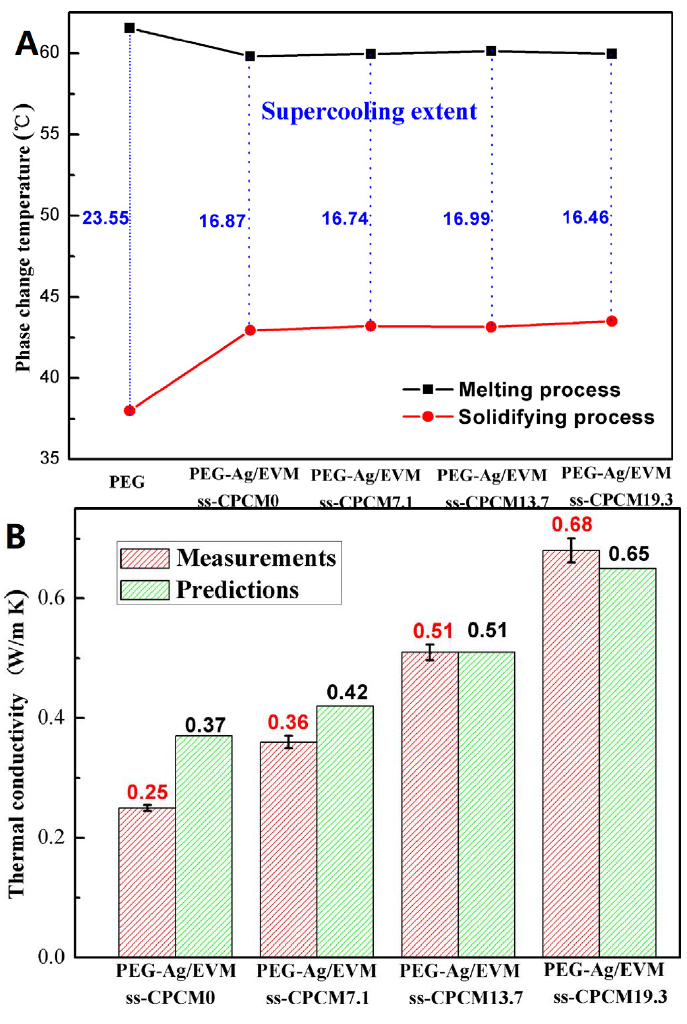
Figure 14. ( A ) Supercooling degrees of PEG and PEG-Ag/EVM ss-CPCMs with different concentration of AgNWs and ( B ) measured and predicted thermal conductivities of PEG-Ag/EVM ss-CPCMs at 20 °C [79].